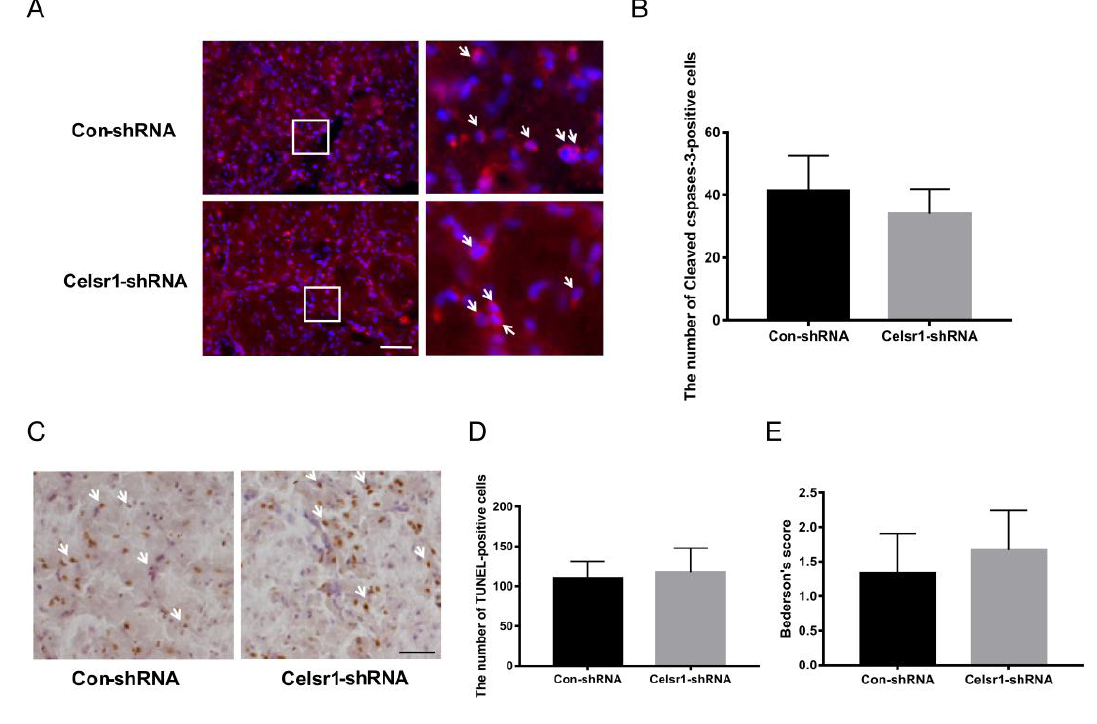
Figure 6. Celsr1 knockdown in the DG had no effect on the number of apoptotic cells in the ischemic penumbra. ( A ) Cleaved caspase-3 staining (red) in the ischemic penumbra, DAPI (blue) was used to label the nuclei. The insets white box to show photomicrographs of the cells at higher magnification. Arrows point to caspase-3-positive cells. Scale bar = 45 µ m. ( B ) The number of cleaved caspase-3-positive cells was not di ff erent, as determined by quantitative analysis after Celsr1 knockdown in the DG. ( C ) TUNEL staining was used to show apoptotic cells. Arrows point to TUNEL-positive cells. Scale bar = 45 µ m. ( D ) No di ff erence was found in the number of TUNEL-positive cells by quantitative analysis ( n = 3 per group). ( E ) The Bederson score showed no change after Celsr1 knockdown in the DG ( n = 3 per group).